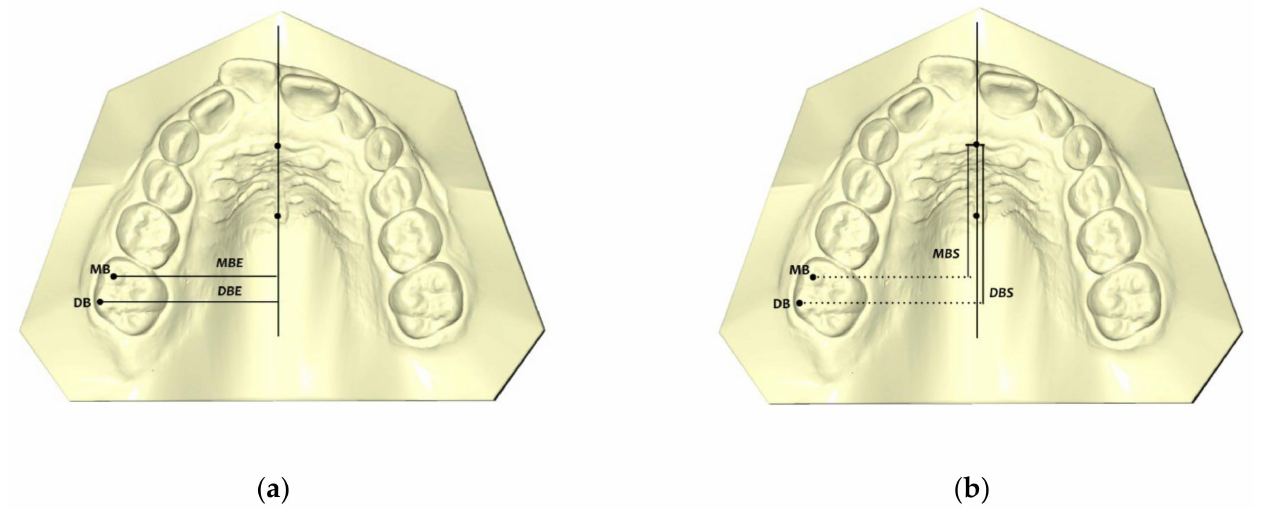
Figure 2. ( a ) Linear measurements of the expansion (MBE, DBE) movements of the upper first molar mesiobuccal (MB) and distobuccal (DB) right or/and left cusps. ( b ) Linear measurements of the distalization (MBS, DBS) movements of the upper first molar mesiobuccal (MB) or/and distobuccal (DB) right and left